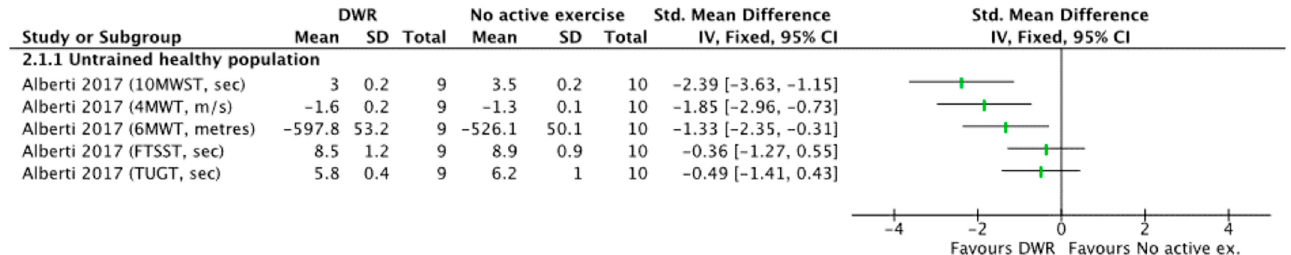
Figure 5. Standardized mean difference (95% CI) for the effect of DWR compared with land train ‐ ings on physical function outcomes [26,28].